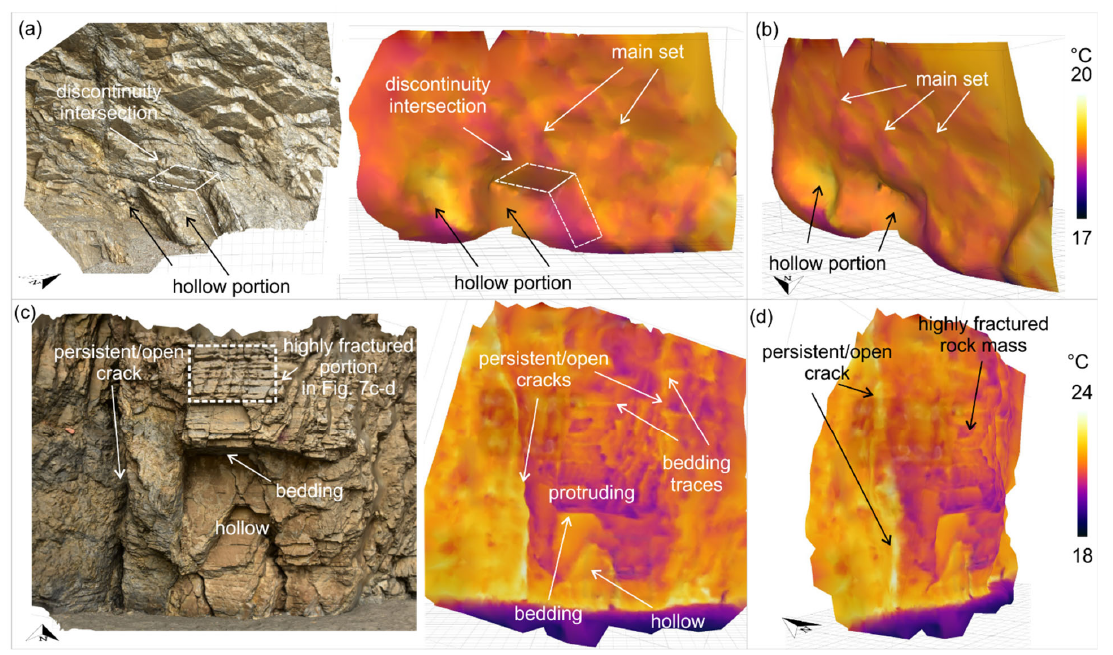
Figure 6. Thermal point clouds generated from overlapped thermograms: ( a ) frontal view of both point clouds (RGB and IRT) belonging to RM1 with the main elements highlighted; ( b ) lateral view of the thermal point cloud belonging to RM1; ( c ) frontal view of both point clouds (RGB and IRT) belonging to RM2 with the main elements highlighted; ( d ) lateral view of the thermal point cloud belonging to RM2.